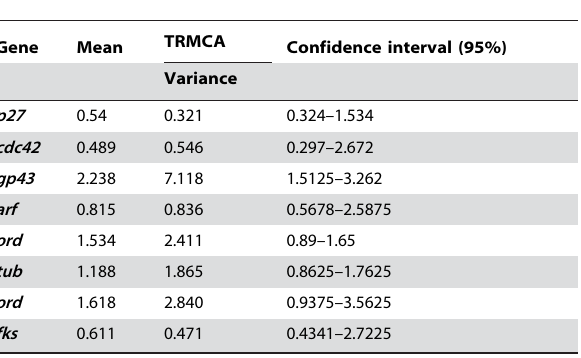
Table 6. Maximum-Likelihood Estimates (MLE) and the 95% confidence intervals of Time to the Most Recent Common Ancestor